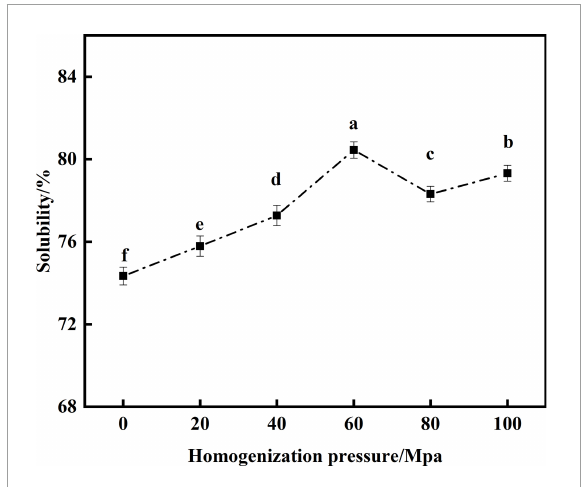
FIGURE6 Effects of high-pressure homogenization (HPH) on the solubility of enzymatic hydrolyzed soybean protein concentrate (SPC).